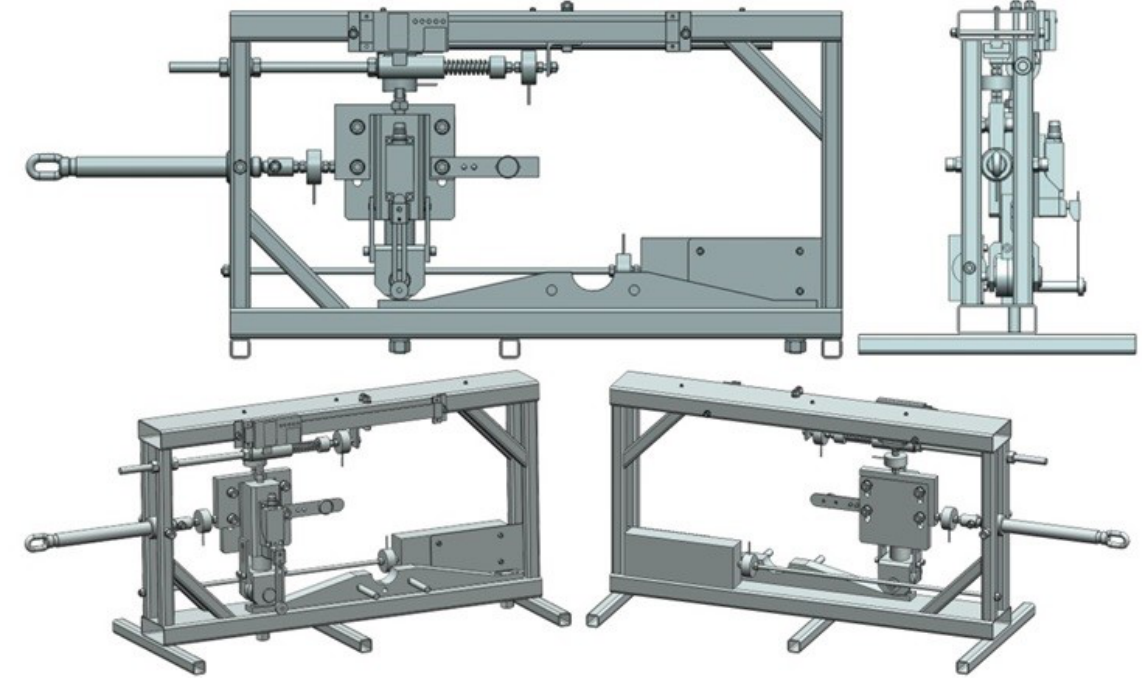
Figure 10: Equipment for the testing of pallets arresting system